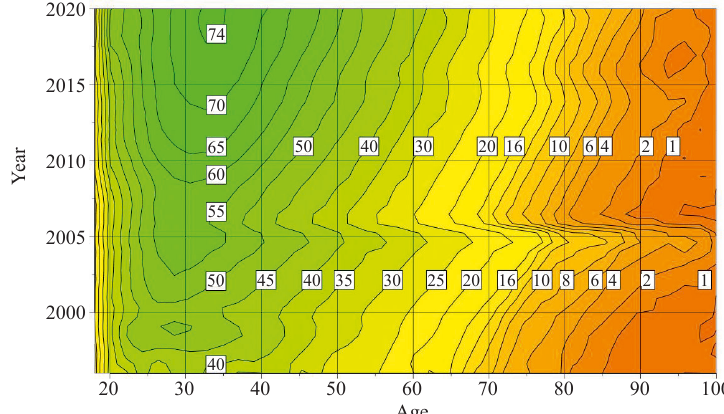
Figure 6. Percentage of Latvian population with valid